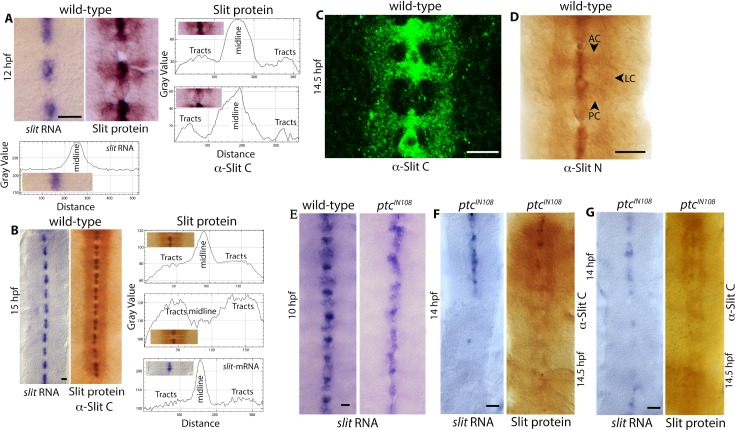
The expression of Slit is progressively lost from the midline and tracts in an anterior-posterior direction in ptc mutant embryos.(A, B):Wild-type embryos were examined for slit transcription by RNA whole mount in situ (alkaline phosphatase, AP) and Slit protein (anti-Slit-C) by DAB-histochemistry. The image analysis was done using the ImageJ software and shown as expression profile plot. The yellow-rectangle in the inset photomicrograph marks the area of ImageJ analysis. The slit transcription is restricted to the midline glia, and the Slit protein is present in midline glia as well as in axon tracts of commissures and longitudinal connectives. Scale bar: Panel A, 10 μm; panel B, 8 μm. (C, D): Wild-type embryos were stained with anti-Slit-C and the signals were detected using a fluorescently labeled secondary antibody and confocal microscopy (C, single section-plane), or stained with anti-Slit-N and detected with DAB-histochemistry (D). Note the presence of Slit in commissures and connectives. AC, anterior commissure; PC, posterior commissure; LC, longitudinal connectives. Scale bar: 8 μm. (E): The expression of slit RNA in 10 hpf wild-type and ptc mutant embryos. No loss of slit expression is detected at this age. Scale bar: 8 μm. (F): The expression of slit mRNA and protein in 14 hpf wild-type and 14.5 hpf old ptc mutant embryos. The expression (both the mRNA and the protein) is progressively lost from the midline as well as from the tracts in an anterior-posterior direction (compare panel F to panel B). Scale bar: 8 μm. (G): In a minority of ptc embryos, loss of Slit expression was less organized, although the posterior region was more affected. In such embryos as well, the narrowing of tracts phenotype correlated with the loss of abundance of Slit in tracts. Scale bar: 8 μm.